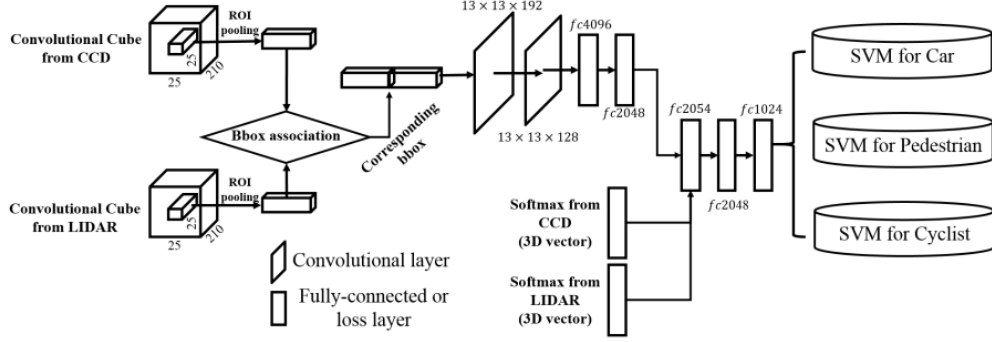
Figure 5. Architecture of the fusion network. Bbox denotes bounding box (Section